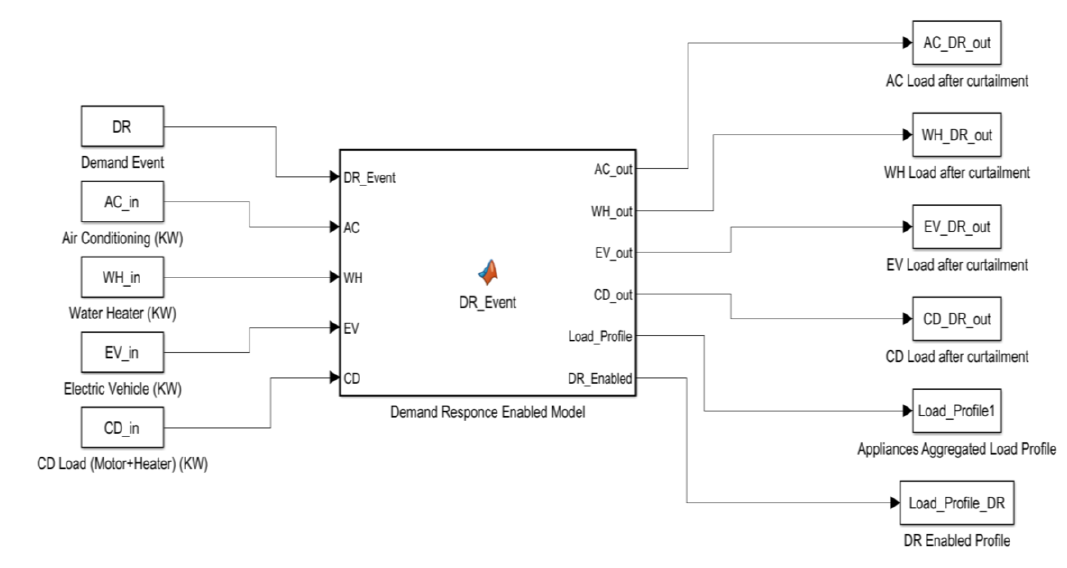
Figure 5. MATLAB/Simulink model of HEMS.